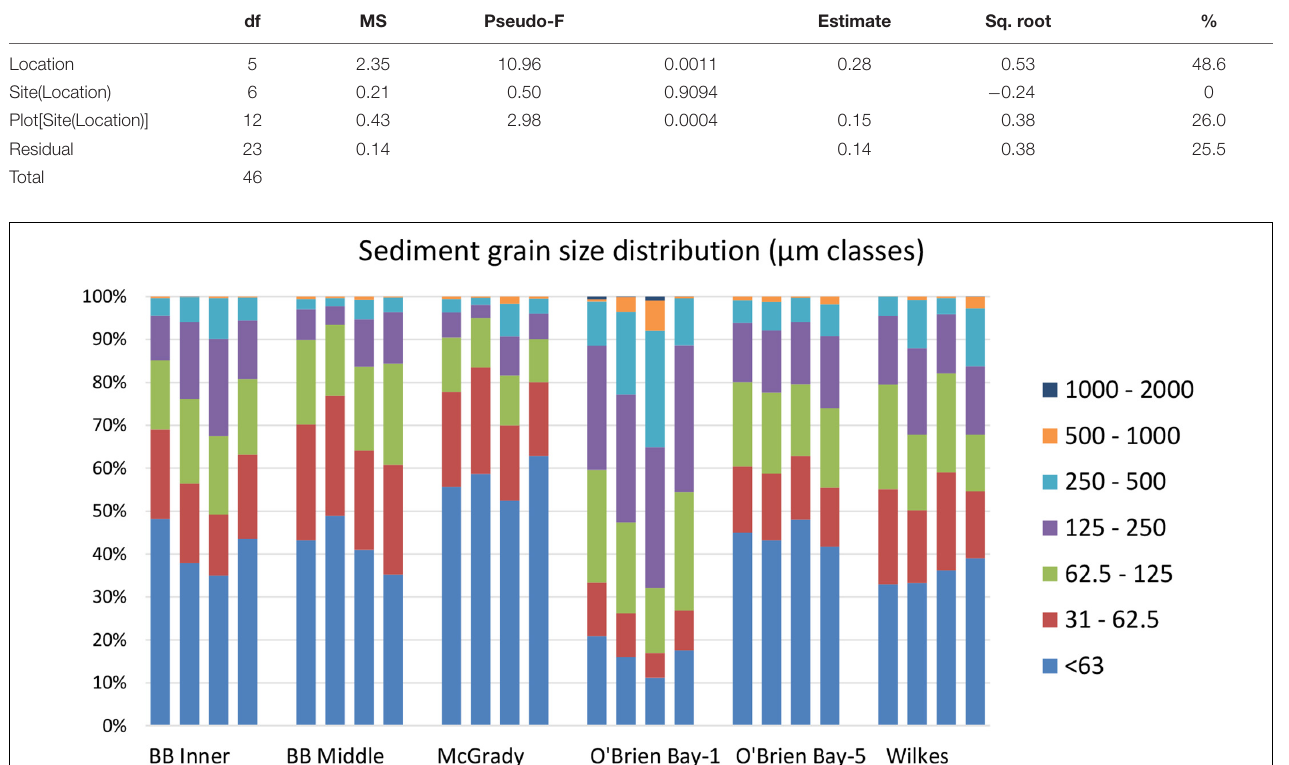
TABLE 5 | Results of PERMANOVA analyses for grain size of sediments at Casey Station, with estimated components of variation (ECV) derived from PERMANOVAs. Source